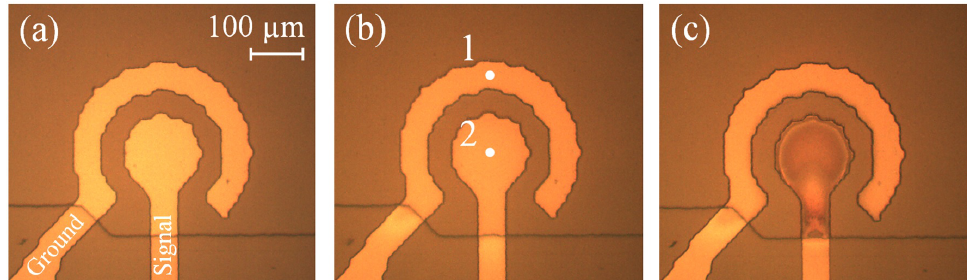
Figure 8. Photos of the concentric electrodes: ( a ) before the test; ( b ) after 60 min of operation in the normal regime; ( c ) after 60 min of operation in the current stabilization